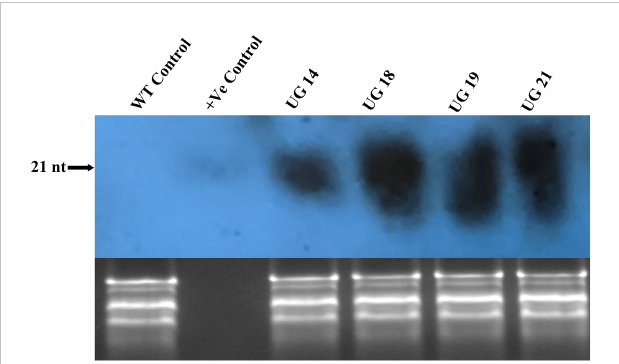
FIGURE 7 Small RNA northern blot of the UGPase RNAi transgenic potato lines of KC4. siRNA band corresponding to ~21nt long positive control oligo was detected in the fourRNAi transgenic lines. Lanes: Lanes: WT, wild type control; +ve, positive control; UG14, UG18, UG19, UG21 represent transgenic potato lines.